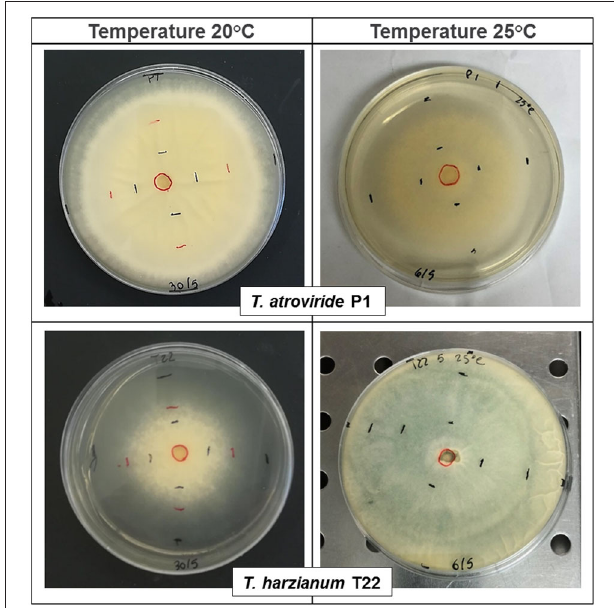
FIGURE 1 | Effect of temperature, at 20 ◦ C (left) and 25 ◦ C (right), on the mycelial growth of Trichoderma atroviride P1 and T. afroharzianum T22 after 72h. Measurements were conducted every 24h, as indicated by the black/red markings delineating the periphery of the fungal colony. The fungi were cultured on potato dextrose agar (PDA) and maintained at a constant temperature of 20 ± 1 ◦ C or 25 ± 1 ◦ C and photoperiod of 16: 8h light/dark.